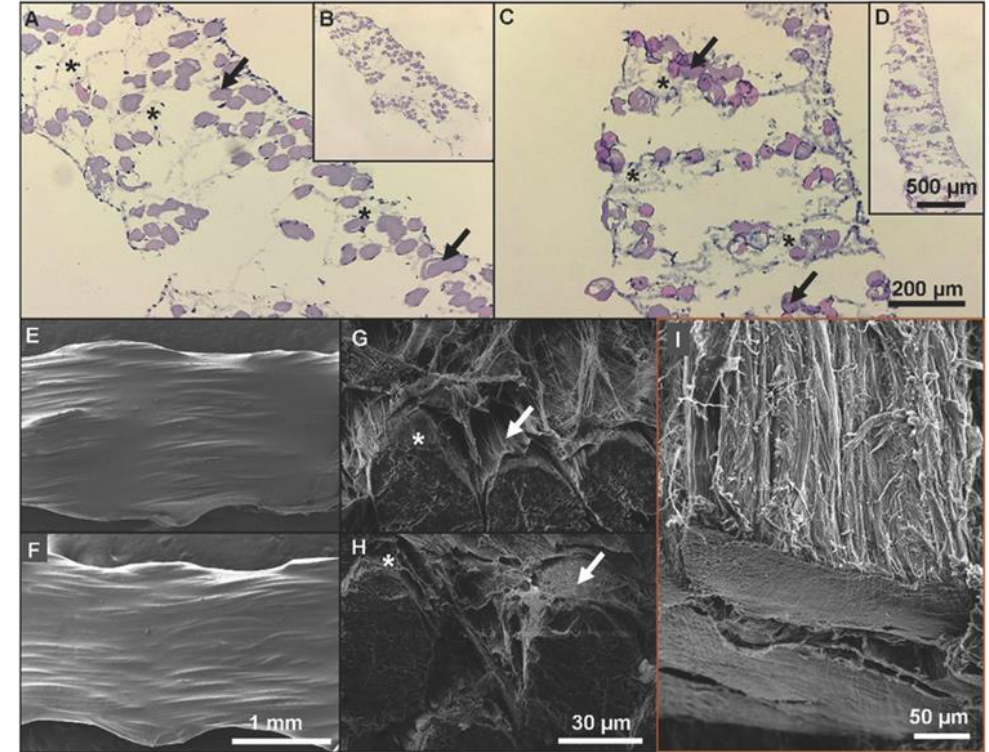
Figure 4. Data obtained by Laranjeira M. et al. [43] presenting cell infiltration and ECM organization on a 3D weave. The histological cross-sections of the scaffolds cultured with cells after 42 days: ( A , B ) hTDCs; ( C , D ) hASCs (* ECM deposition; → threads stained in pink, while cell nuclei were stained in blue-purple); ( E – H ) SEM images show a layer of ECM covering the scaffolds cultured with hTDCs; ( E , G ) and hASCs; ( F , H ) after 21 days; ( I ) SEM images of a bovine posterior cruciate ligament show a structure similar to both seeded scaffolds. (Figures with the license provided by John Wiley and Sons and Copyright Clearance Center, license number 5483771495280.)